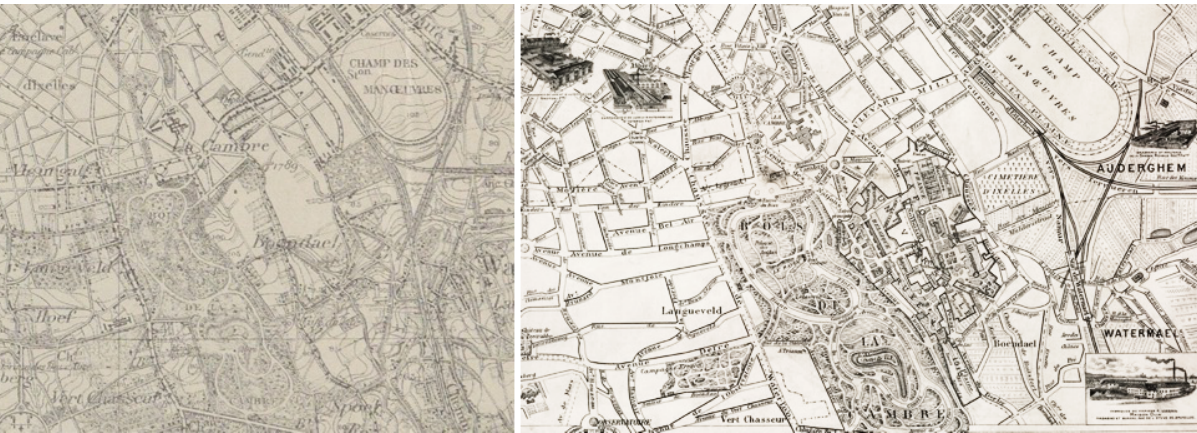
Figure 4. Detail of the Solbosch plateau, site of the 1910 Brussels World’s Fair (IGN, 1910; Verwest et al., 1910a). Courtesy of the Ghent University Library and of the Archives de la Ville de Bruxelles (plan de Bruxelles no. 130, section